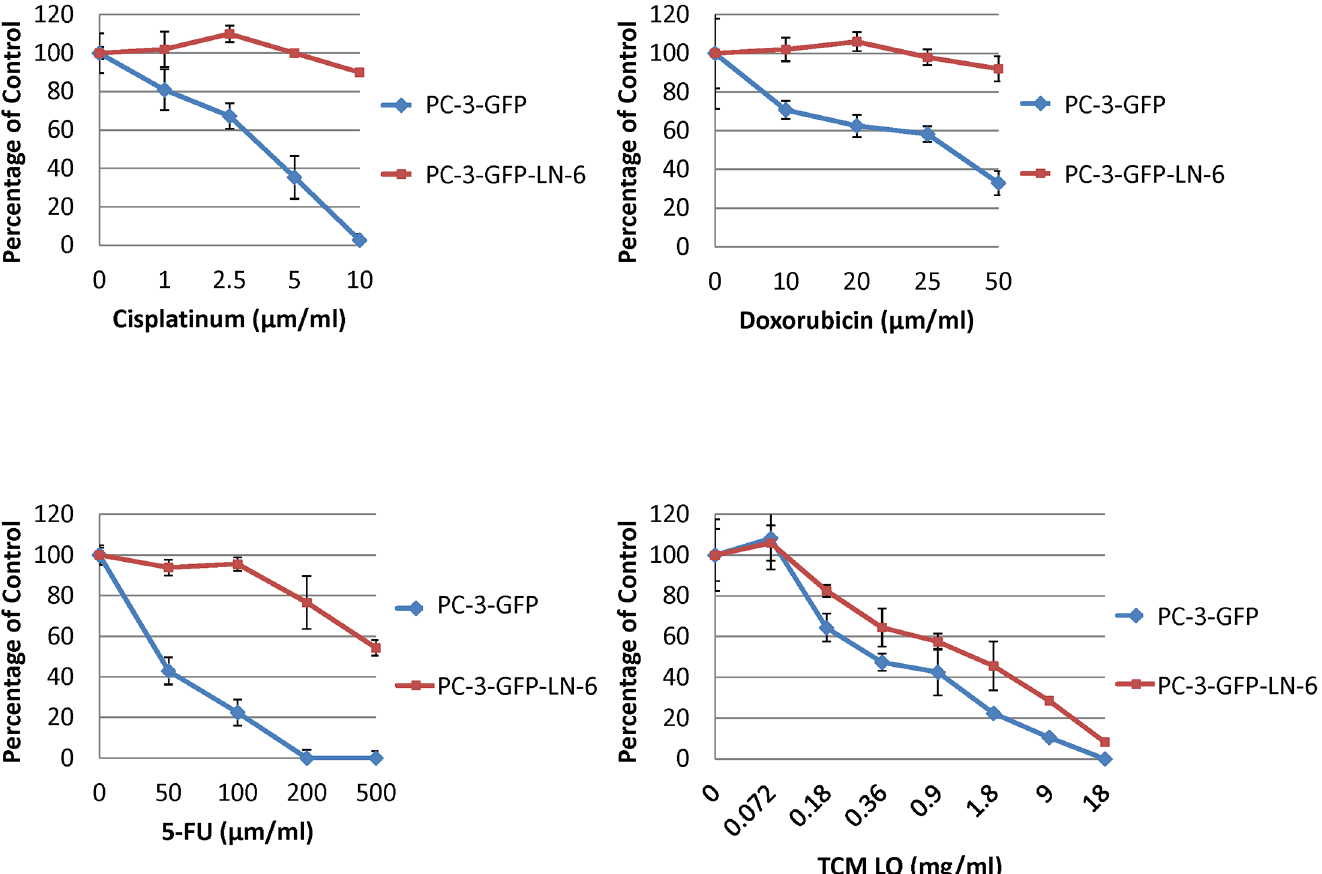
Fig 3. Sensitivity of the PC-3-GFP-LN3-6 cells to 5-fluorouracil (5-FU), cisplatinum (CDDP), doxorubicin (DOX), and traditional Chinese medicine herbal mixture LQ. PC-3-GFP-LN-6 was highly-resistant to all chemotherapeutic drugs tested compared to the parental PC-3-GFP cells ( p < 0.01). PC- 3-GFP-LN-6 only showed similar sensitivity to the parental cell line PC-3-GFP when treated with TCM LQ.